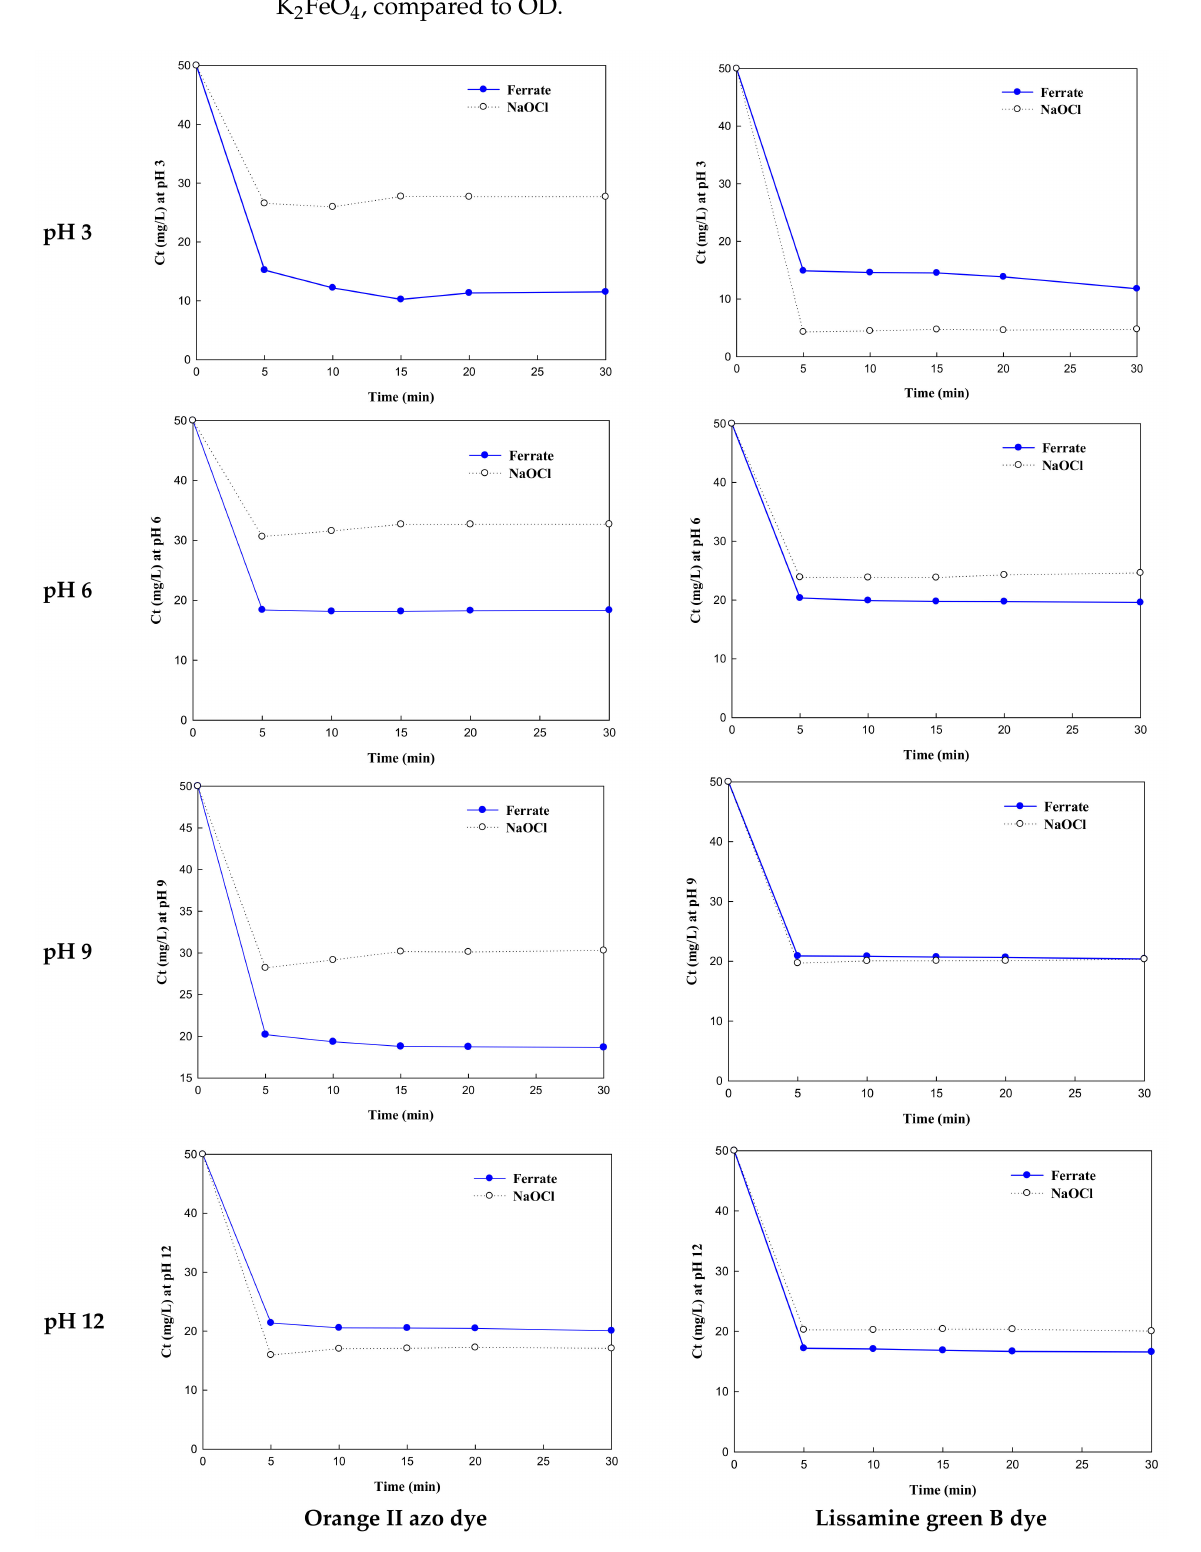
Figure 2. Reaction rates of potassium ferrate and NaOCl with orange II azo dye and lissamine green B dye under different pH conditions (3, 6, 9, and 12). Dye concentration: 50 mg/L; K 2 FeO 4 : 56.40 mg/L as Fe; NaOCl: 56.40 mg/L as Cl 2